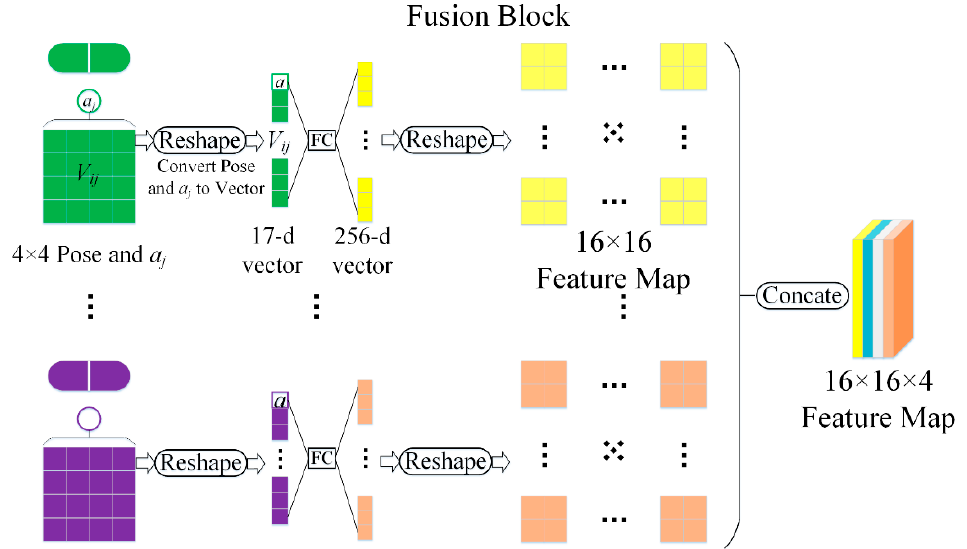
Figure 4. Illustration of converting matrix capsule features to feature maps.